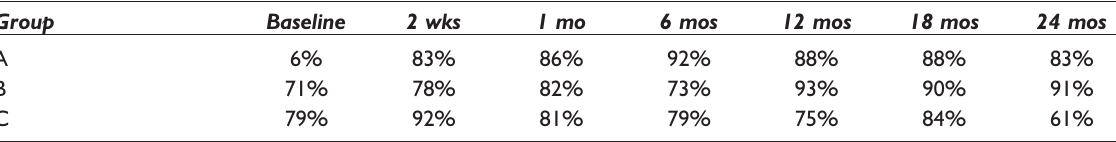
Table 1 Percentage of CVL HIV-1RNA 5 400 copies/ml by group over all follow-up visits